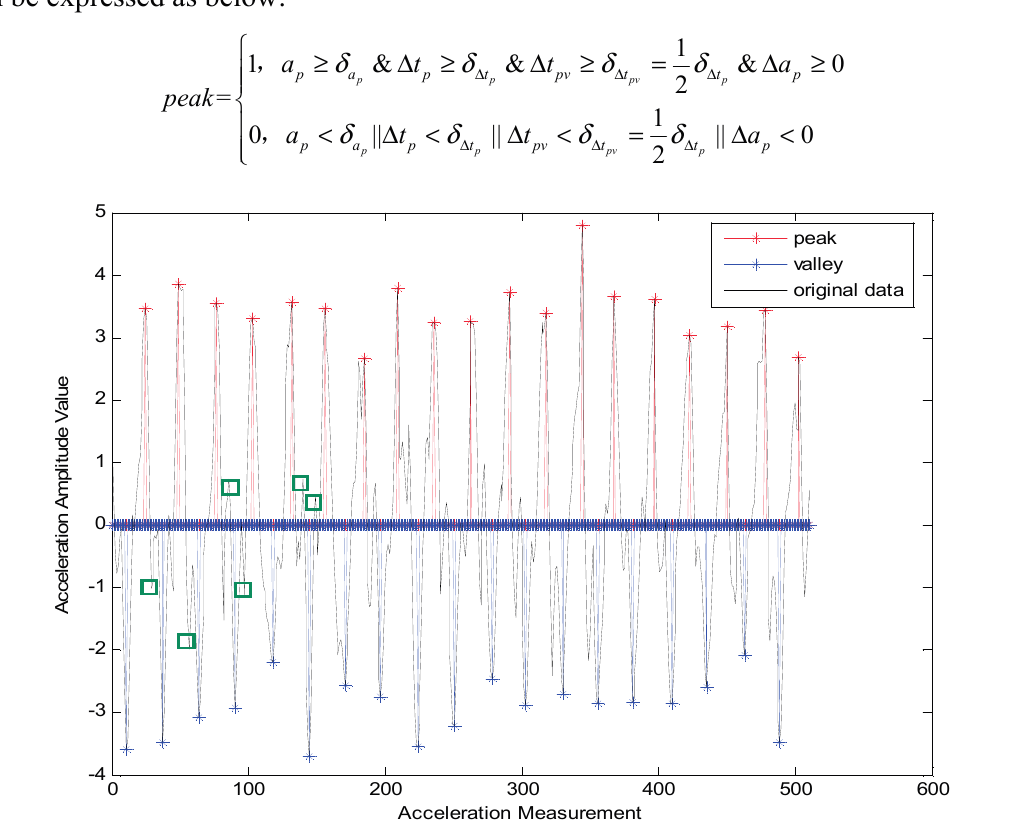
Figure 3. Faulty step detection induced by a pseudo-peak and a